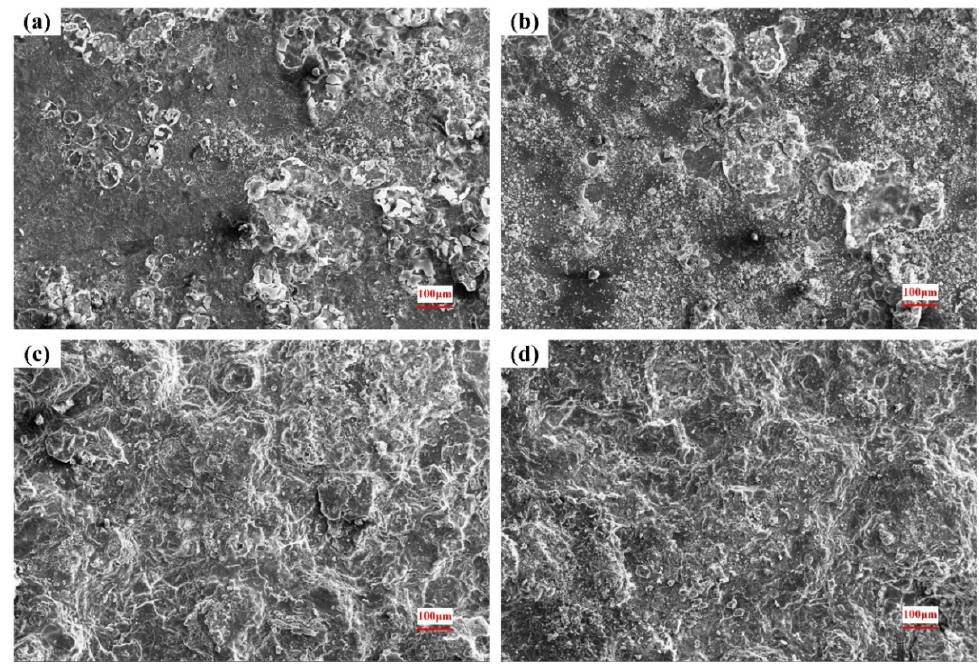
Figure 10. Surface morphology after corrosion in 0.6 mol/L Cl − solution: ( a ) 4 h; ( b ) 8 h; ( c ) 18 h; ( d ) 36 h.